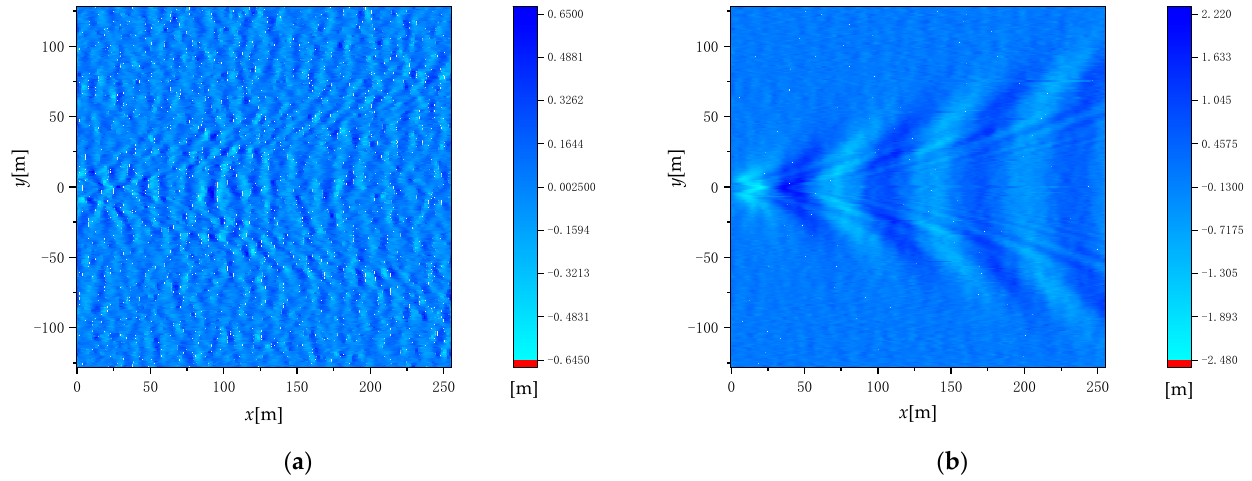
Figure 5. Wave height after linear superposition of time-varying Kelvin wake and time-varying sea surface for ( a ) U s = 5 m/s and ( b ) U s = 10 m/s.